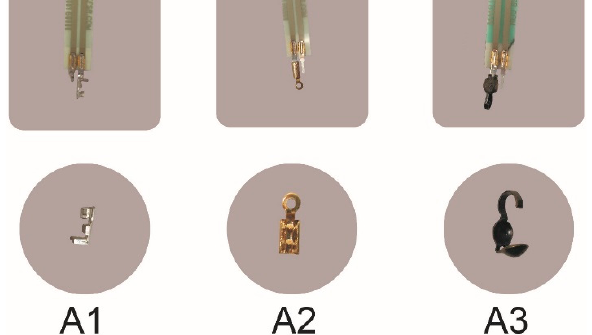
Figure 3. Different possibilities for crimped connections composed of different joints and sensors.